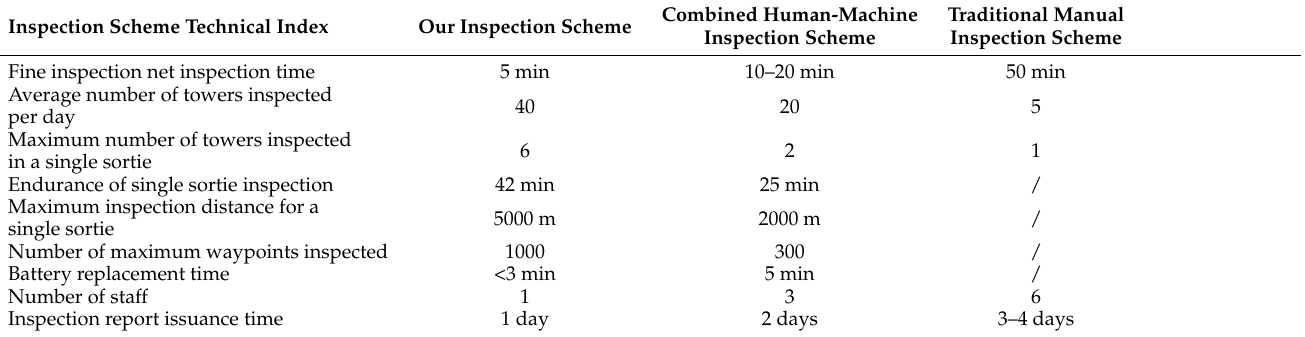
Figure 15. Comparison of the detection results of the different models. The red rectangular box is the detection result of the model, inside the yellow border is the incorrect detection result, and inside the blue border is the correct detection result. Table 7. Comparison of performance indicators of different inspection